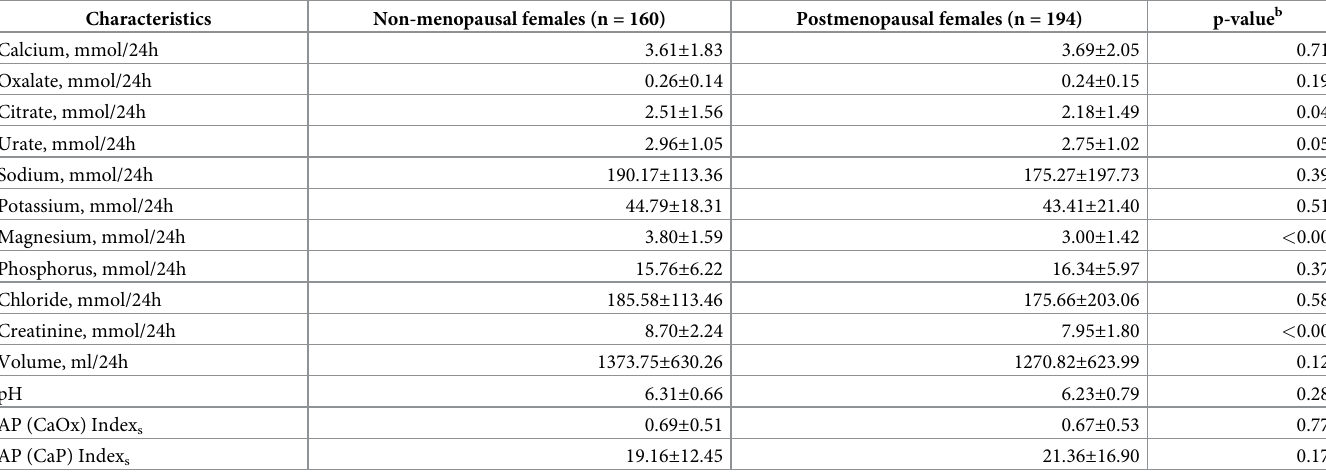
Table 2. Univariable analysis of 24-hour urine composition between non-menopausal and postmenopausal women a .